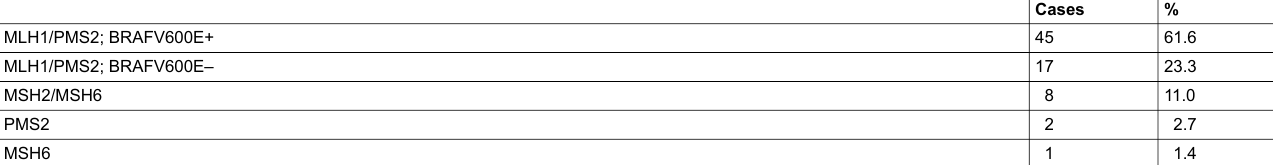
Table 2: Distribution of loss of expression of the DNA mismatch repair (MMR) genes in MMR deficient group.